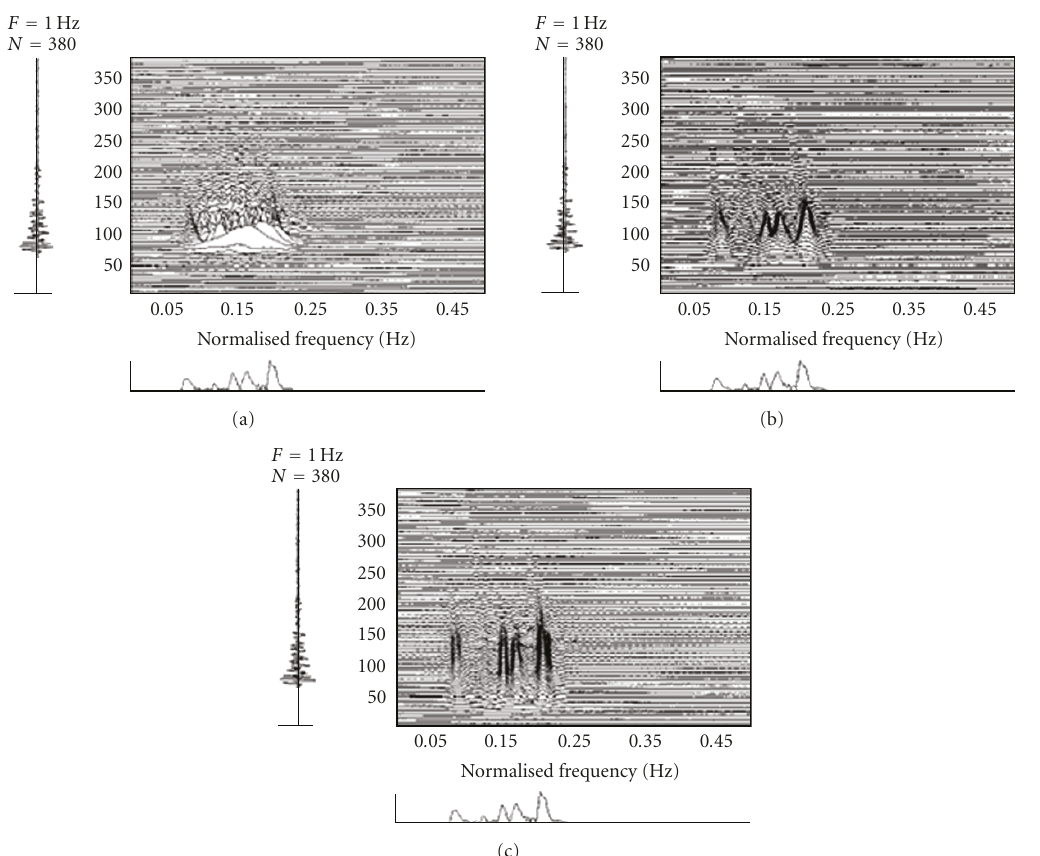
Figure 13: (a) WVD, (b) the spectrogram, and (c) the proposed TFD for a real-life automotive signal (adopted from Barkat and Boashash